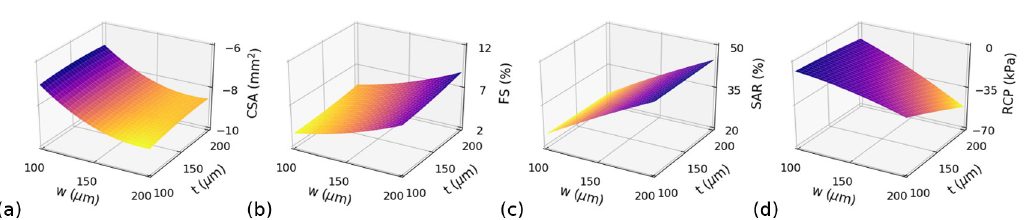
Fig 12. Response surfaces highlighting the combined influence of w and t on each performance metric (CSA, FS, SAR and RCP), holding A r and l constant at their baseline values ( A r = 1.35 and l = 1050 μ